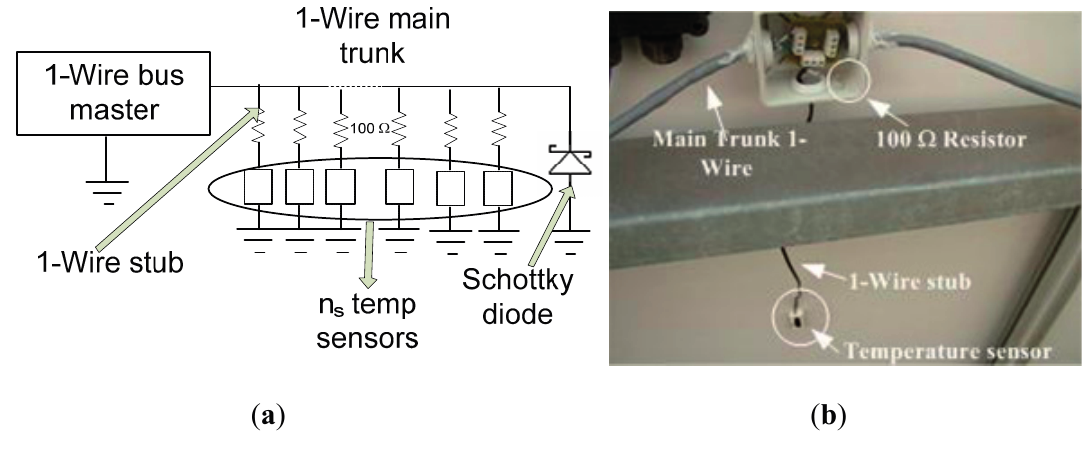
Figure 3. ( a ) Improved design of the network topology; ( b ) Details of the field implementation (the rear of each panel).